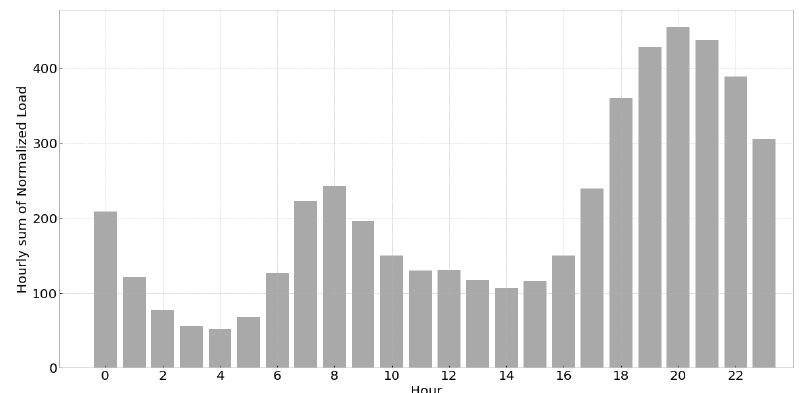
Figure 1. Hourly sum of normalized load of all residential